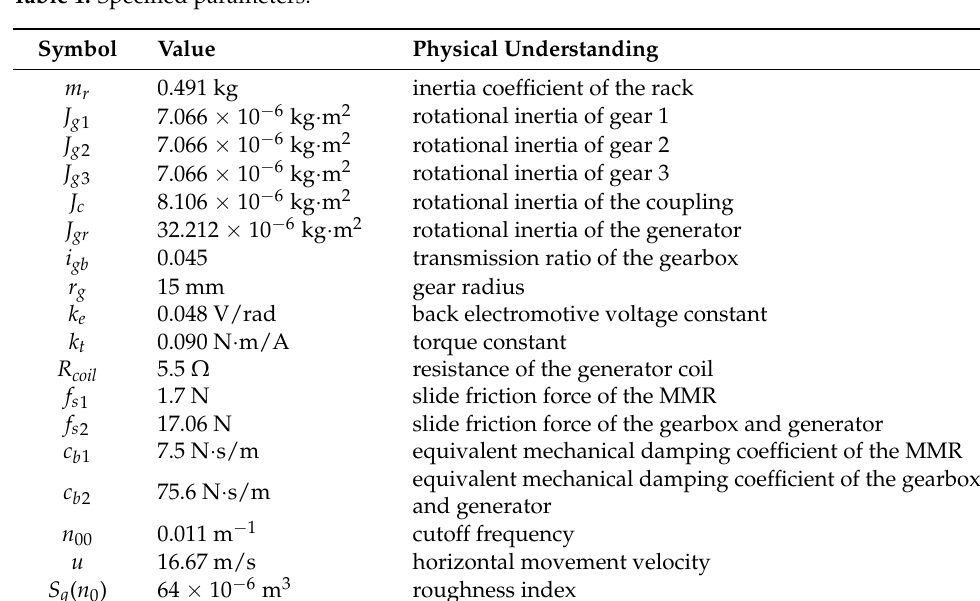
Figure 1. Structure of the MMR − EHSA. Table 1. Specified parameters.